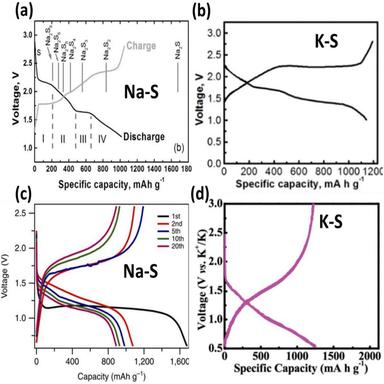
Typical voltage profiles of (aeb) S8 species and (ced) small sulfur molecules or chemically bonded S species in NaeS and KeS batteries. a) Reprinted (adapted) with permission from Ref.. Copyright 2017 John Wiley and Sons. b) Reprinted (adapted) with permission from Ref. . Copyright 2018 Elsevier. c) Reprinted (adapted) with permission from Ref.. Copyright 2013 John Wiley and Sons. d) Reprinted (adapted) with permission from Ref.. Copyright 2019 American Chemical S